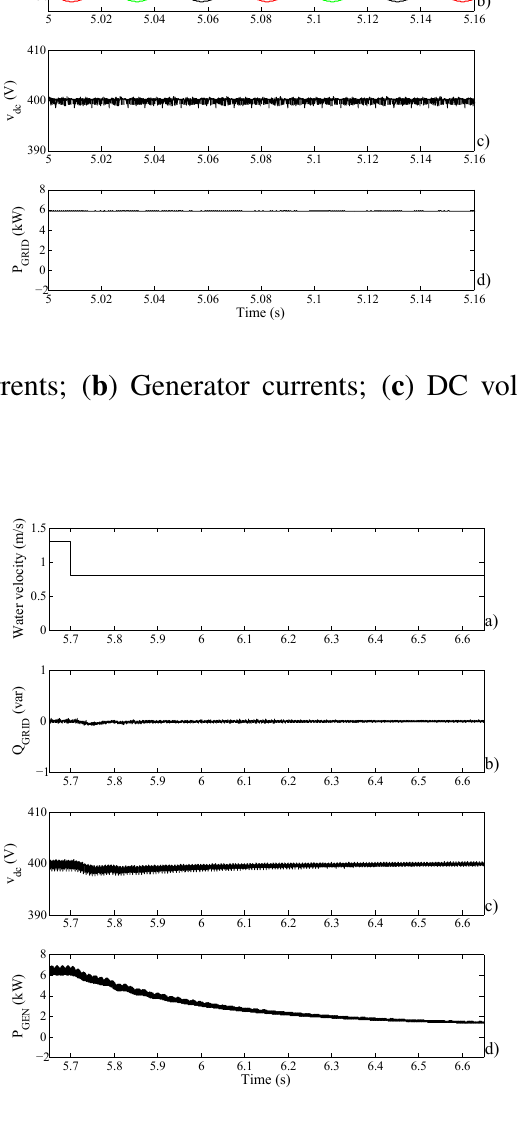
Figure 8. ( a) Step in water velocity; ( b ) Grid reactive power; ( c ) DC voltage; ( d ) Generator